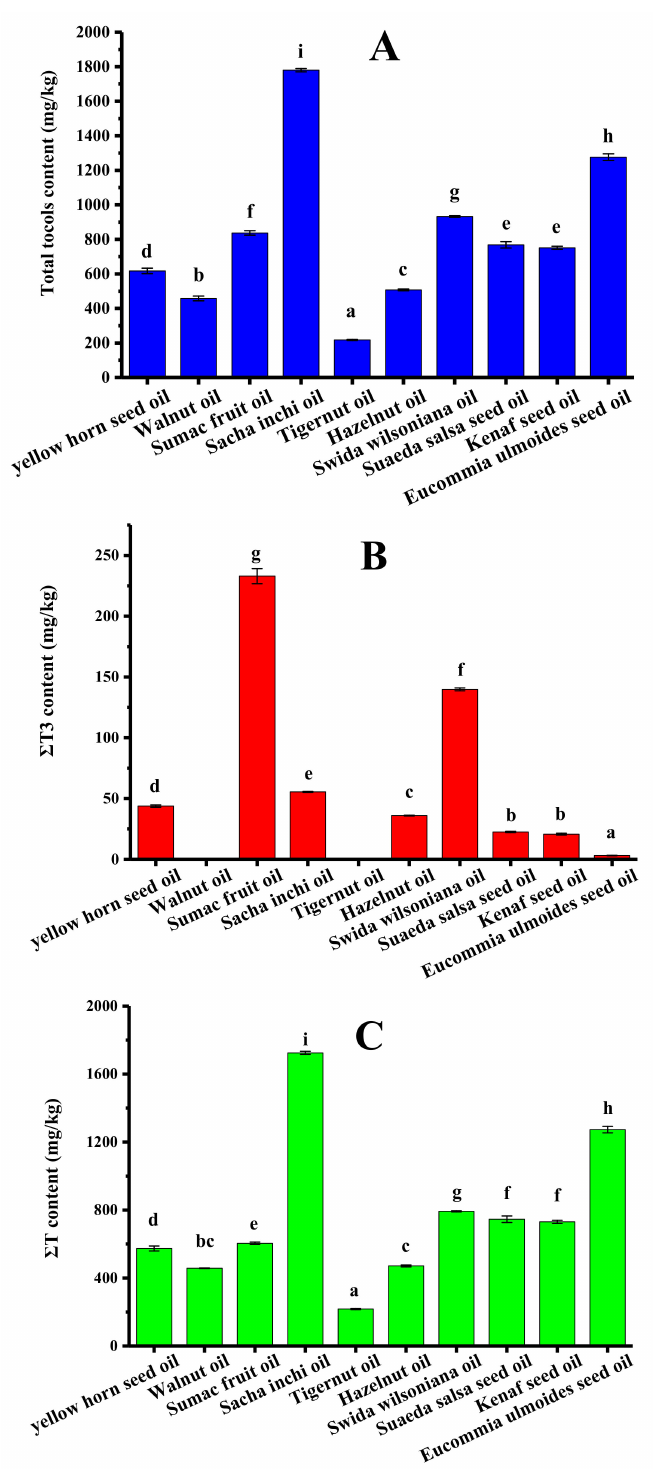
Figure 5. The tocol contents in di ff erent new types of vegetable oil (mg / kg). ( A ) Total tocol content; ( B ) Σ T3 content; ( C ) Σ T content (samples with the same letter in a column are not significantly di ff erent ( p < 0.05) n =